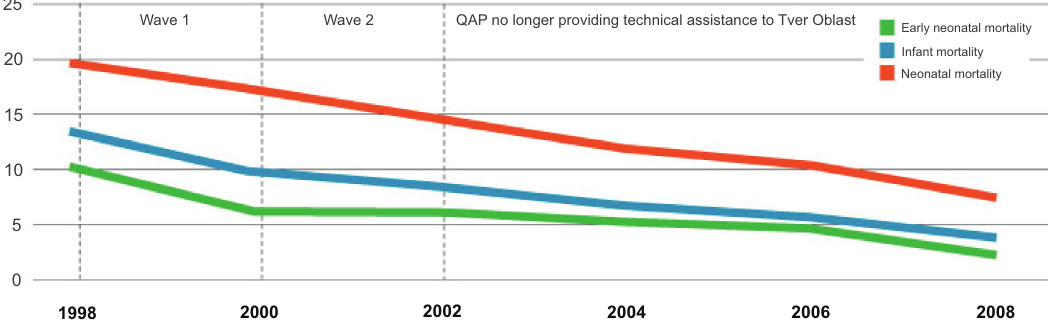
Figure 4. Tver, Russia: improvement of neonatal outcomes. The reduction in early neonatal mortality, the neonatal mortality and the infant mortality during the demonstration phase, spread phase and for six years after the end of USAID QAP’s technical assistance to Tver Oblast are shown. Significant improvements in mortality were achieved and sustained beyond the life of the project. This data comes from Tver Oblast Health Authority surveillance system.